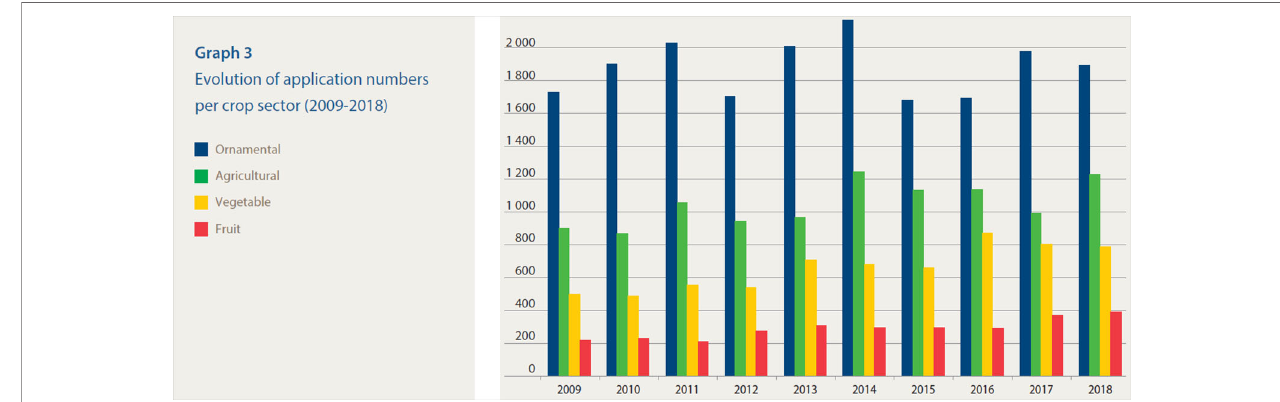
FIGURE 1 | Evolution of PBR-application numbers per crop sector (2009 – 2018) at the